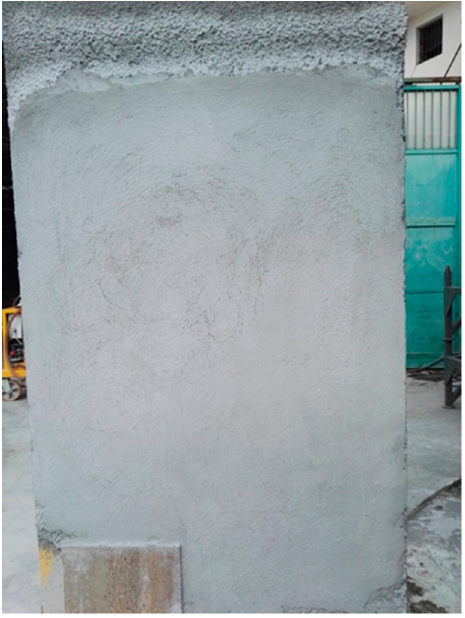
Figure 6. Pouring plaster results after two days from its application on the panel.